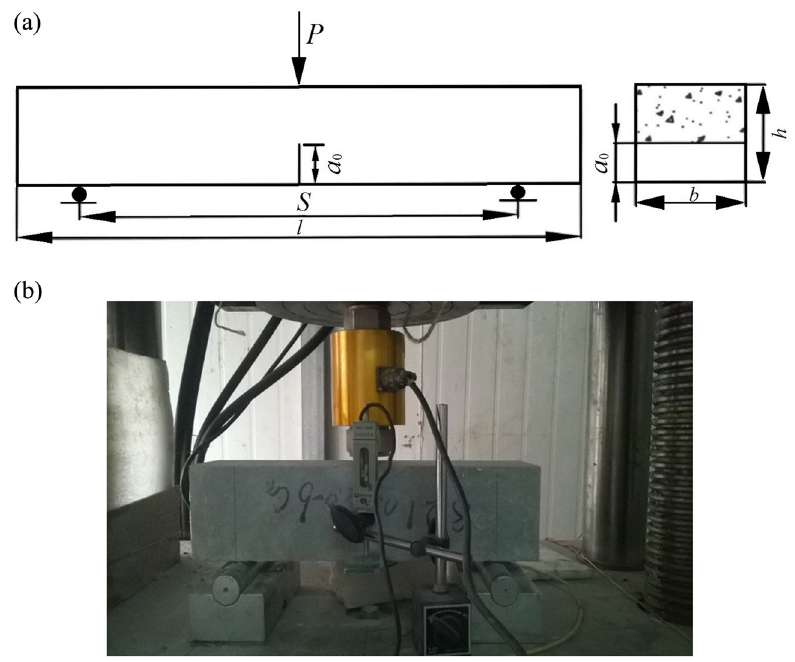
Figure 2: Fracture properties test: ( a ) dimension of specimen, ( b ) setup of the bending